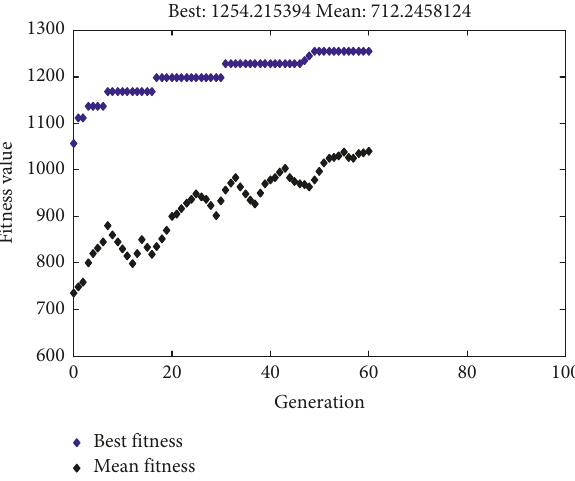
Figure 4: Import of goal function and constrains.